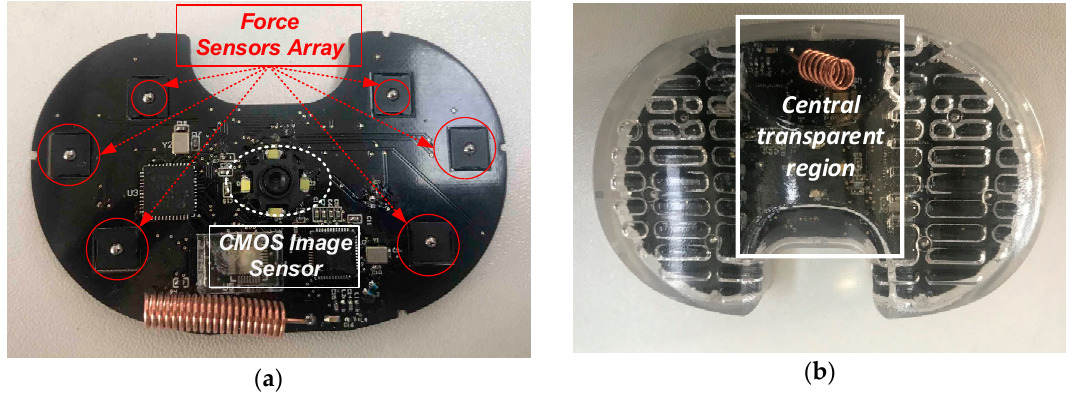
Figure 5. Package and assembling of the sensing device. ( a ) printed circuit board (PCB), ( b ) the entire sensing device with the transparent shell.